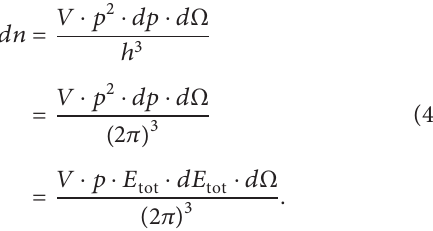
Figure 2: Observables of neutrinoless double 𝛽 -decay 𝑚 ) (red) versus the cosmologically relevant sum of neutrino mass eigenvalues ∑ 𝑚(𝜈 𝑚(𝜈 𝑒 hierarchy (b). The width of the bands/areas is caused by the experimental uncertainties ( 2𝜎 ) of the neutrino mixing angles [15] and in the case alsobythecompletelyunknownMajorana-andCP-phases.Uncertaintiesofthenuclearmatrixelements,whichenterthedetermination of 𝑚 ee from the measured values of half-lives or of half-live limits of neutrinoless double 𝛽 -decay, are not of 𝑚 ee